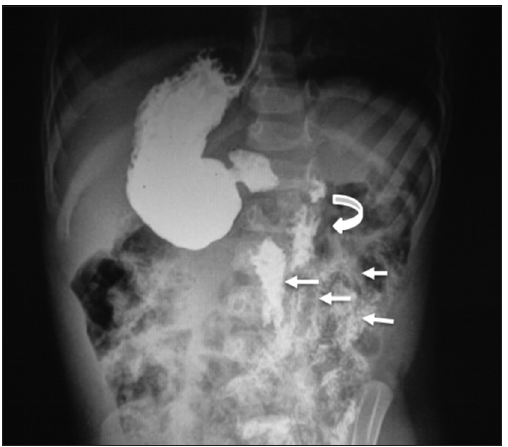
Figure 3: Follow-up UGI contrast study - the reverse duodenal C drops (curved arrow) lead to the duodenojejunal junction and proximal jejunal loops (arrows) placed to the left of midline in a “reverse” Ladd’s position